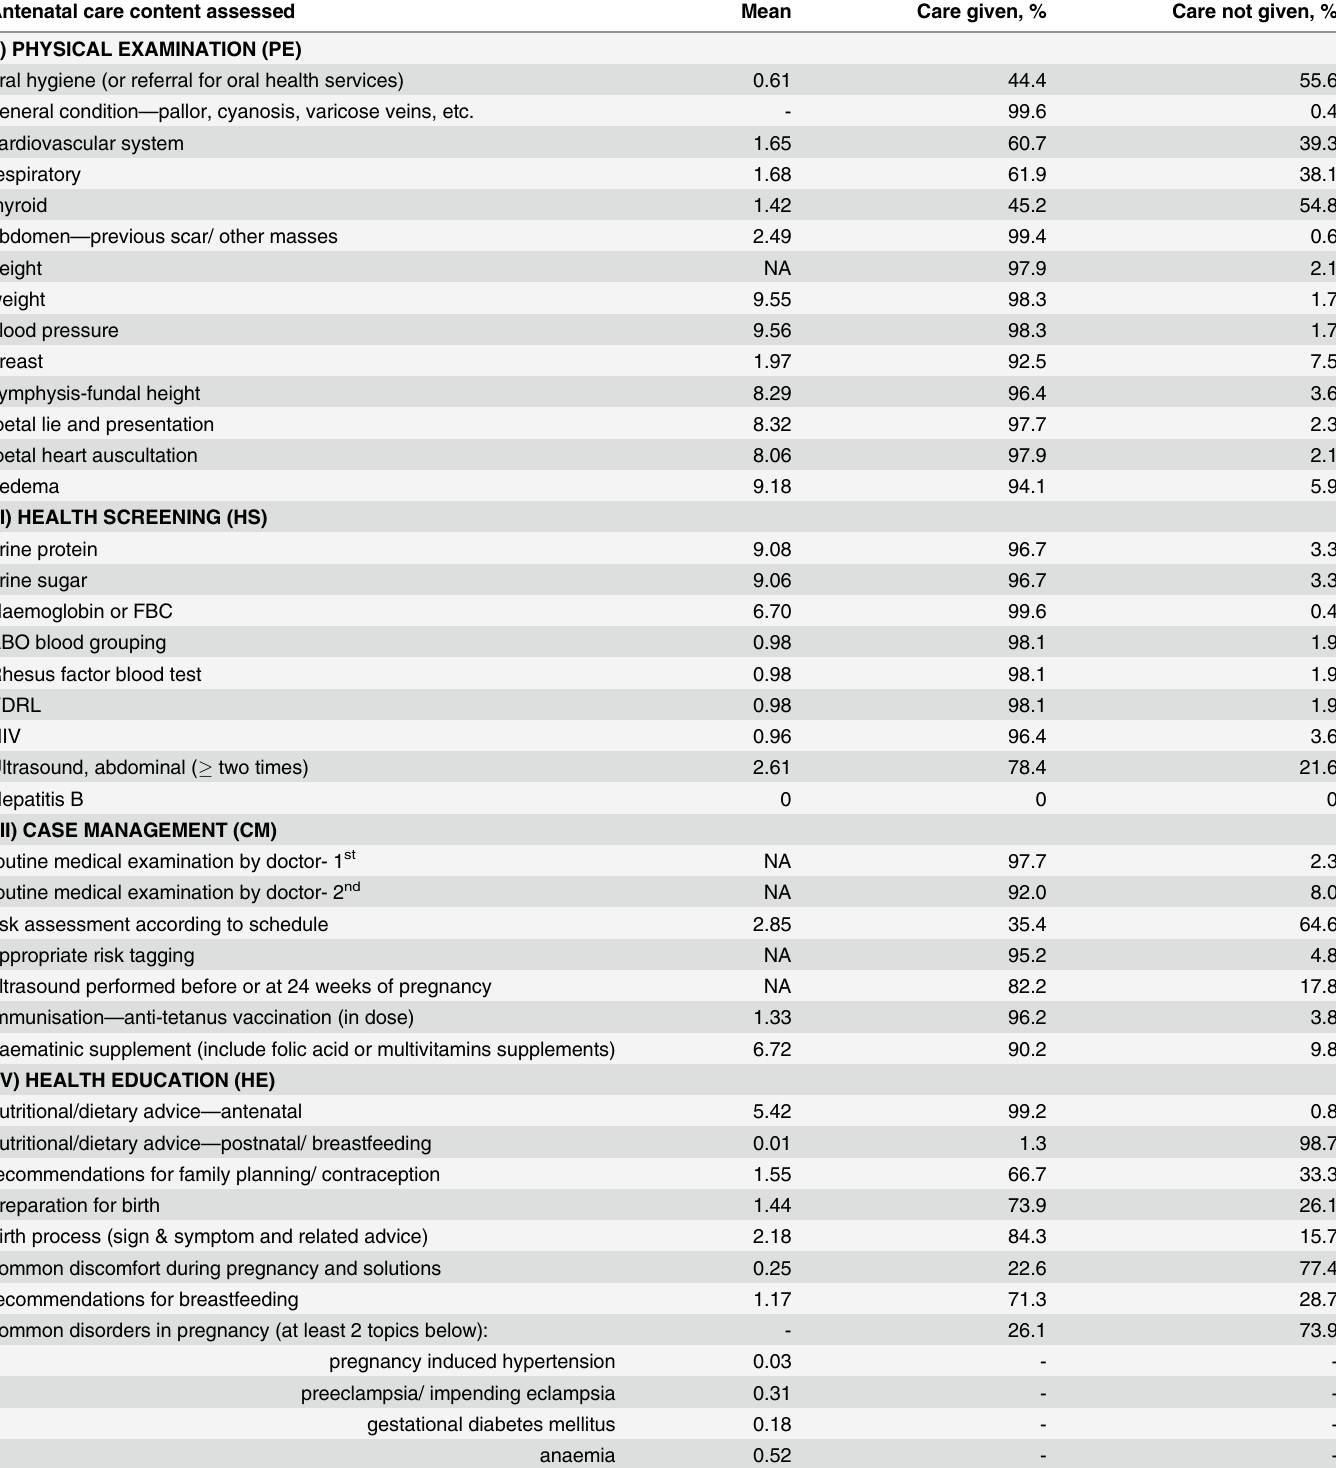
Table 1. Documented antenatal care content provided to pregnant women, mean of number of times performed, and percentage of pregnant women given care according to compliance criteria (n = 522). Antenatal care content